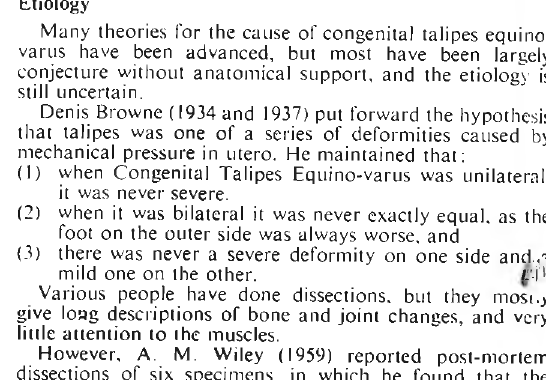
Fig. 1 : Untreated congenital talipes equino-varus.